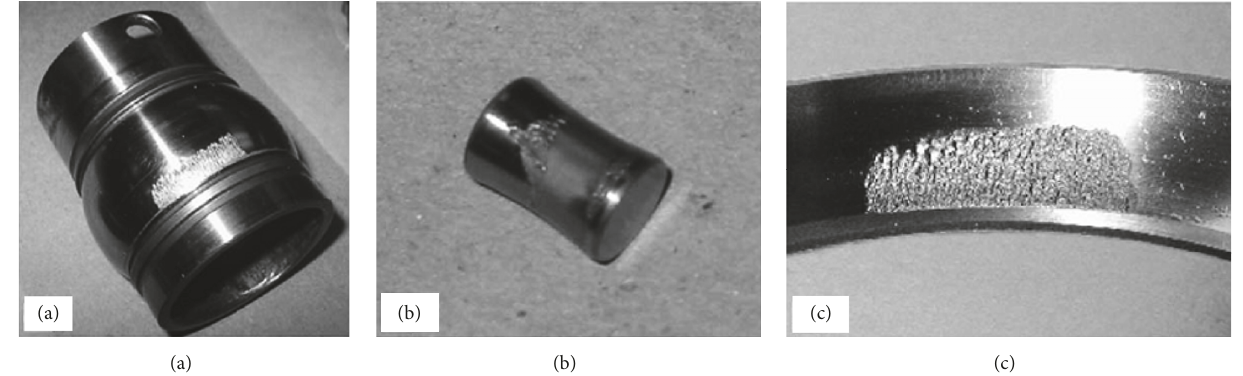
Figure 3: Components of failure bearing: (a) inner race defect; (b) roller element defect; (c) outer race defect.